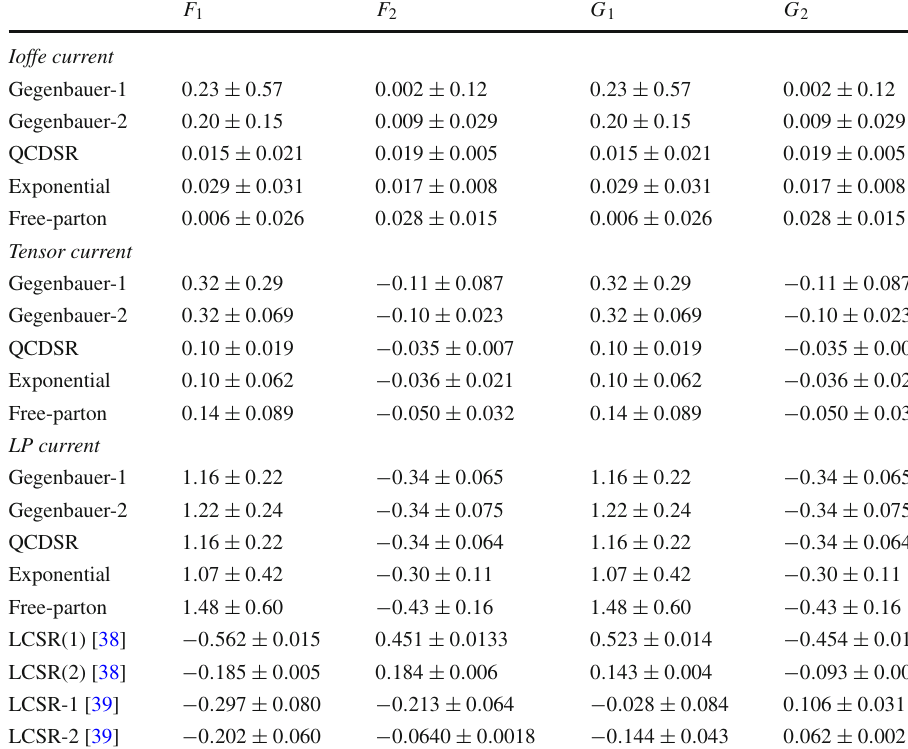
Table 2 The results of form factors f i and g i for (cid:2) b → N ∗ at q 2 = 0 under three interpolating currents for the N ∗ (Ioffe, Tensor and LP) with five different LCDA models of (cid:2) b baryon(Gegenbauer-1, Gegenbauer-2, QCDSR, Exponential and Free-parton) in this work. The results for the form factor F 2 ( 0 ) and F 3 ( 0 ) are same, F 2 ( 0 ) = F 3 ( 0 ) , as well as for G 2 ( 0 ) and G 3 ( 0 ) . For comparison, we also collect the results of the form factors from other works